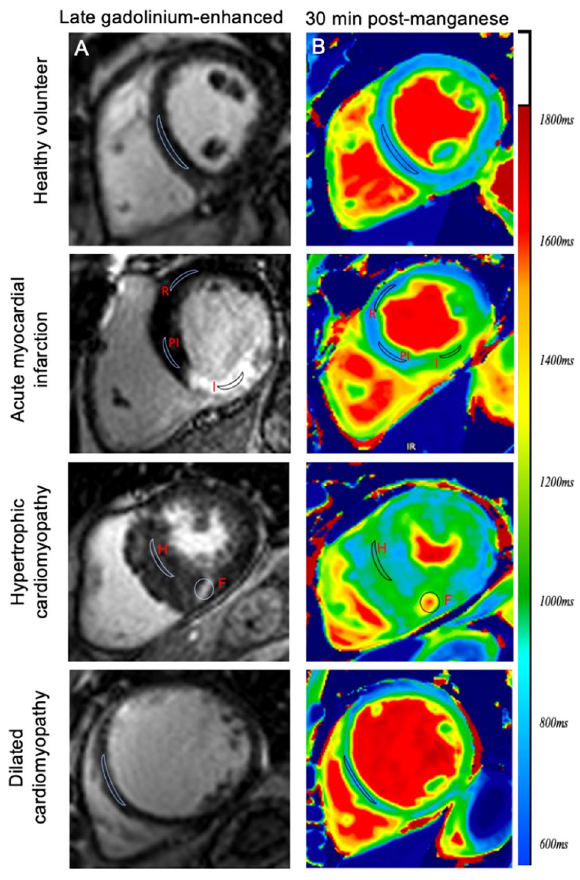
Figure 1. Regions of interest in managanese-enhanced magnetic resonance imaging. Late-gadolinium enhanced ( A ) and 30 min post-manganese T1 maps ( B ) in healthy volunteers, patients with acute myocardial infarction, hypertrophic and dilated cardiomyopathy. Demonstrating regions of interest in healthy volunteers (septum) and patients with acute myocardial infarction (infarct, I, peri-infarct, PI, and remote, R), hypertrophic cardiomyopathy (hypertrophied, non-fibrotic, H and fibrotic, F) and dilated cardiomyopathy